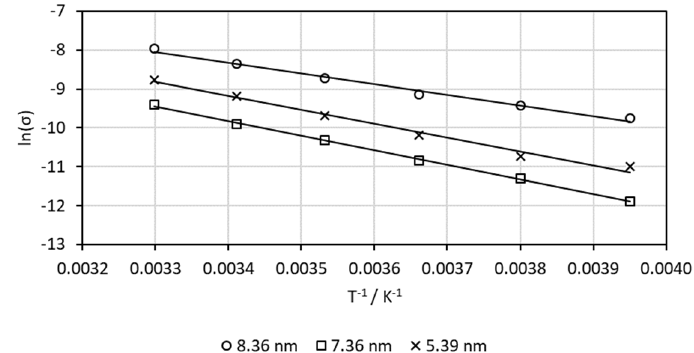
Figure 4. Arrhenius plots for [C 2 mim]FeCl 4 confined in mesoporous SBA-15 silica. Conductiv- ity units are S cm − 1 . Linear regressions are as follows: y = –2750.4x + 1.0278 (R 2 = 0.9891) for 8.36-nm diameter pores, y = –3768.9x + 2.9906 (R 2 = 0.9989) for 7.36-nm diameter pores,